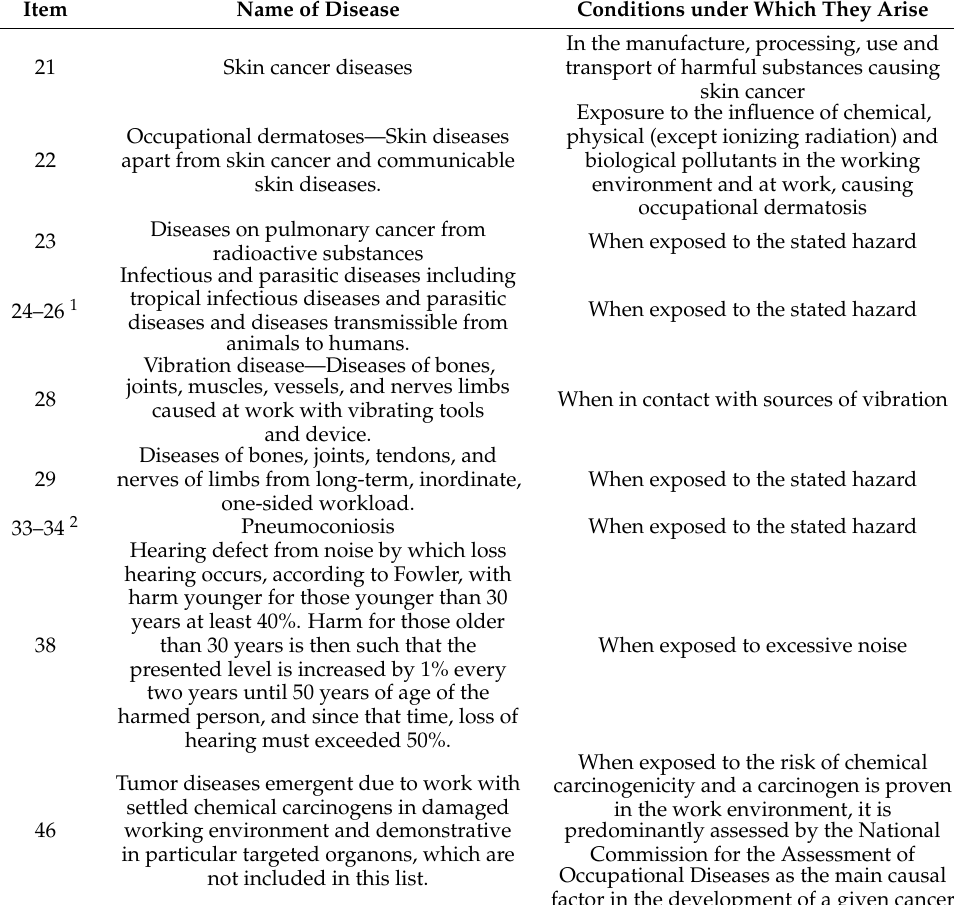
Table 1. Selected occupational